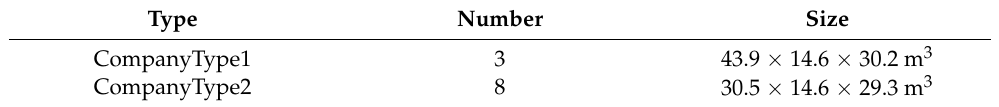
Table 2. Office building